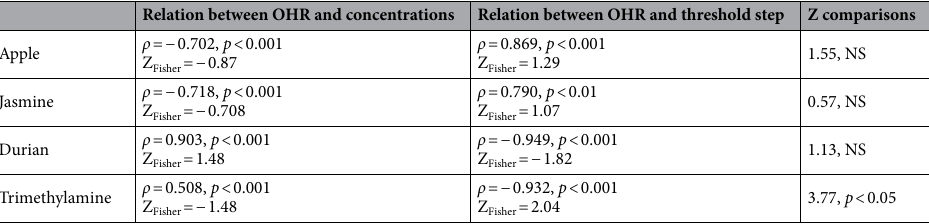
Table 4. Spearman correlations between OHR and concentrations, and between OHR and threshold step for each odor session. Significant results were considered for p < 0.05. It must be noted that the negative correlations values are due to the reverse coding of concentration levels (lower number = higher concentration).